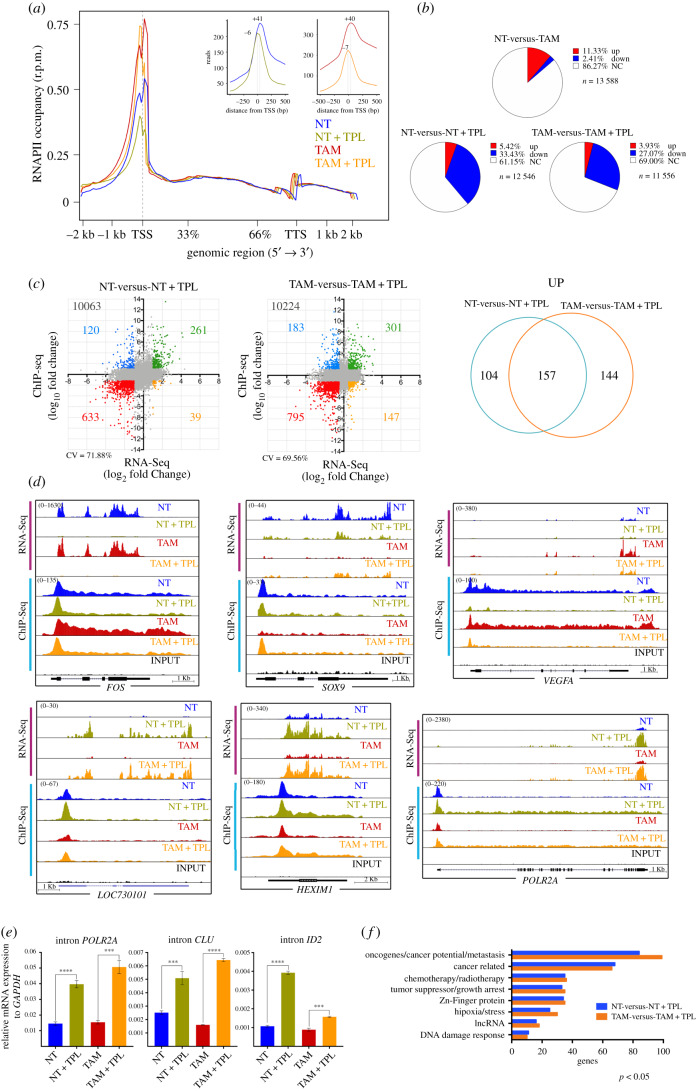
Analysis of the positioning of the RNAPII in cells treated with TPL. ChIP-Seq experiments were performed from two independent biological replicas for each condition. (a) Meta-analysis of the positioning of the RNAPII comparing the non-treated (NT, blue), non-treated + triptolide (NT + TPL, green), Treated with tamoxifen (TAM, red) and Treated with tamoxifen + triptolide (TAM + TPL, orange) treated with TPL for 4 h at 125 nM. The upper right panel shows the displacement suffered by the cells when are treated with TPL towards the TSS-5'. Note the presence of two RNAPII picks, without TPL the major pick corresponds to paused RNAPII and with TPL the major pick corresponds to initiating RNAPII. Also, note that after TPL treatment in some promoters RNAPII is maintained paused. (b) Relation of the occupancy of the RNAPII in gene promoters after the TPL treatment in NT, NT + TPL, TAM and TAM + TPL cells. In red is indicated the promoter occupancy percentage that increases, in blue percentage that goes down and in white promoters that do not have a significant change. (c) Correlation between the RNA-Seq data (x-axis) and ChIP-Seq data (y-axis), from the NT-versus-NT + TPL and TAM-versus-TAM + TPL cells. In green are genes that increase both in transcriptional level and RNAPII positioning in the promoter; in blue genes that increase in transcriptional level but have low positioning in the promoter; in red are the double negative genes, genes with lower transcriptional level and lower positioning in the promoter, while in yellow are genes with low transcript level but increase in the positioning of the polymerase. Correlation value (CV). The right panel shows the number of genes that increase in RNA-Seq and ChIP-Seq, unique and common between NT-versus-NT + TPL cells compared to TAM-versus-TAM + TPL. (d) Examples of the different behaviours observed in the RNA-Seq (pink bar) and ChIP-Seq (blue bar) FOS, SOX9, VEGFA, LOC730101, HEXIM1 and POLR2A. Images are from the Genome Browser. (e) qRT-PCR of intronic sequences to quantify the levels de-novo synthetized mRNAs for genes overexpressed in response to TPL. POLR2A corresponds to the RNAPII large subunit gene, CLU is the clustering gene and ID2 corresponds to the inhibitor of DNA binding gene. In the three genes, an internal sequence of the first intron was evaluated. Data represent three biological and technical replicates. The graph shows mean values ± s.d. (standard deviation). Significant differences were analysed by t-test. Statistical significance is indicated (****p < 0.0001 or ***p < 0.001). (f) Gene ontology of cancer-related genes that were upregulated in the RNA-Seq and the RNAPII occupancy in ChIP-Seq data. Representative plots and graphs in panels (a) to (d) and (f) summarizing the results of two biological replicates from ChIP-Seq analysis.